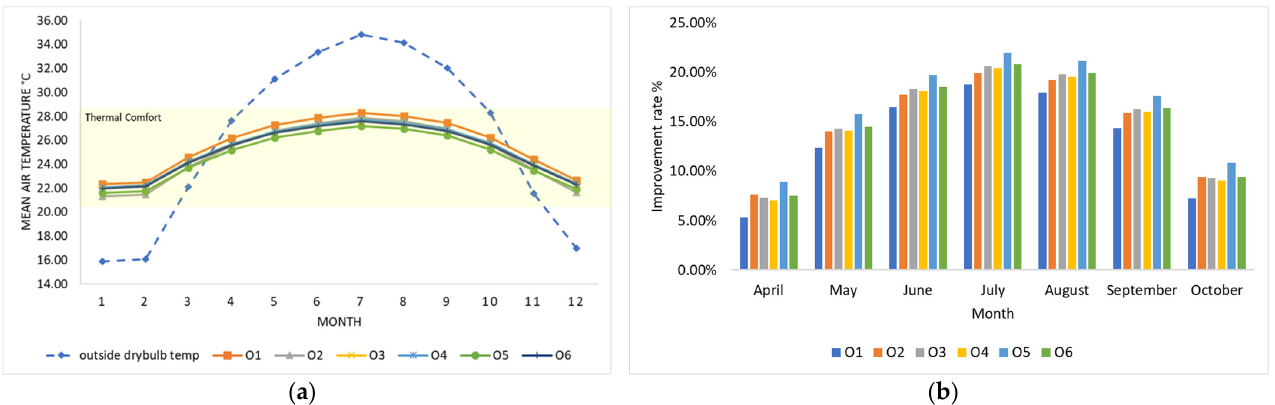
Figure 7. The simulation results in terms of internal thermal conditions using air conditioners: ( a ) the monthly mean air temperature in the salon; ( b ) the improvement rate for the studied options in the hot time of the year.